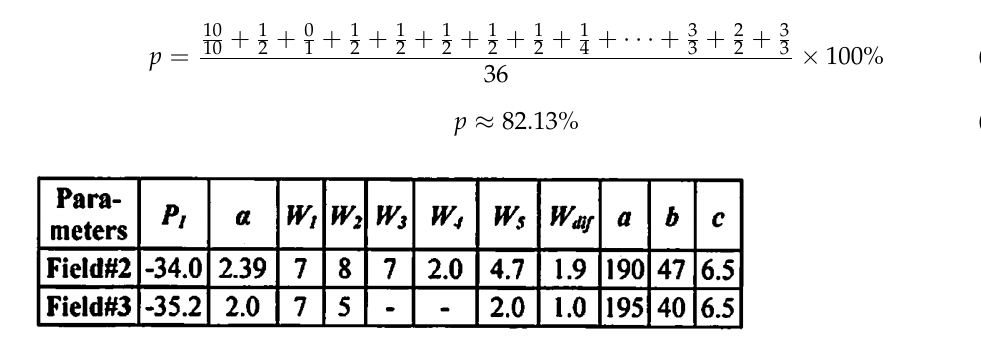
Figure 16. Printed table of scanned table image 2.